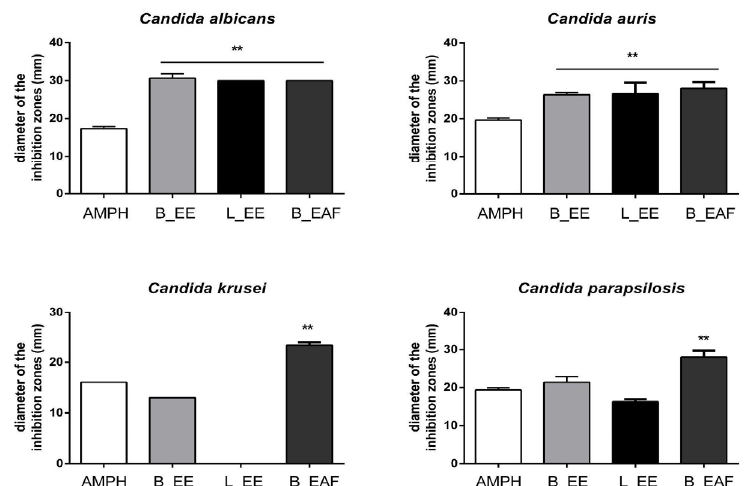
Figure 1. Disk diffusion susceptibility profile of Candida spp. to plant extracts. The diameter of inhibition halo (mm) values were expressed as the mean and standard deviation (n = 3). The values were compared with the amphotericin B group (AMPH, positive control) by an analysis of variance (ANOVA) with Dunnett’s post-test. ** Significant differences were considered as p -values of less than 0.05.